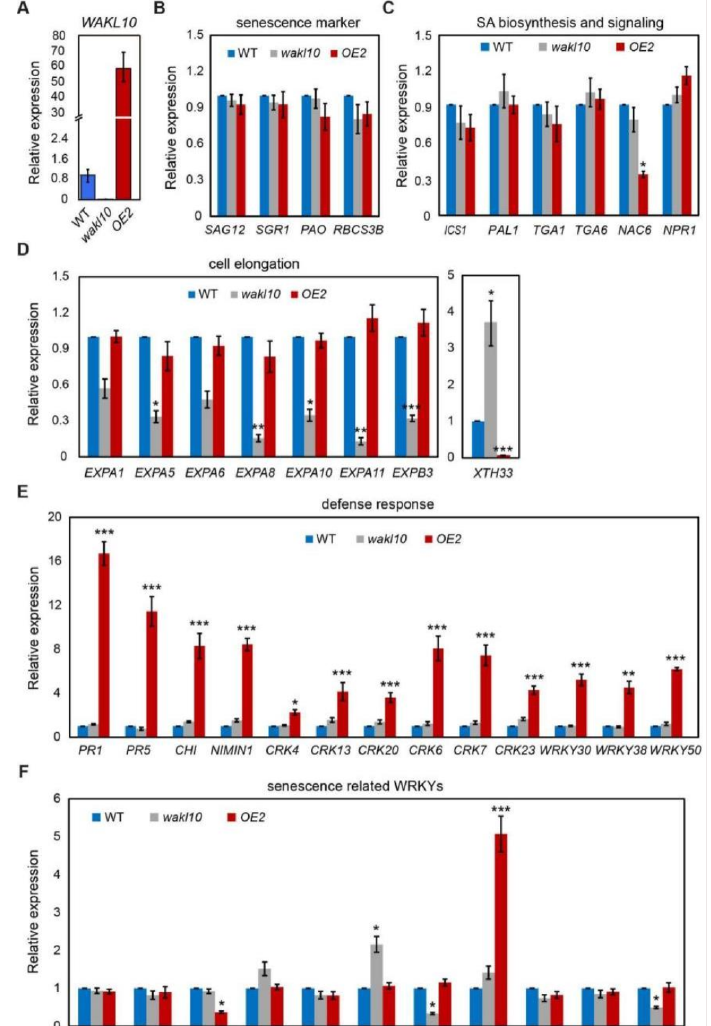
Figure 11. Identification of specific transcriptional changes in atwakl10 mutant and AtWAKL10 overexpression plants with the same degree of senescence as wild type. For all three genotypes as indicated, the sixth and seventh leaves with 20% leaf area from leaf tip yellowing were collected. The relative transcript levels of AtWAKL10 ( A ), senescence markers ( B ), genes involved in SA synthesis and signaling ( C ), cell expansins ( D ), defense responsive genes ( E ), and senescence related WRKY TFs ( F ) were quantified. Data are presented as means ± SE ( n = 30), and significant differences compared with the wild type (Col-0) were determined by Student’s t -test (* p < 0.05; ** p < 0.01 and *** p <